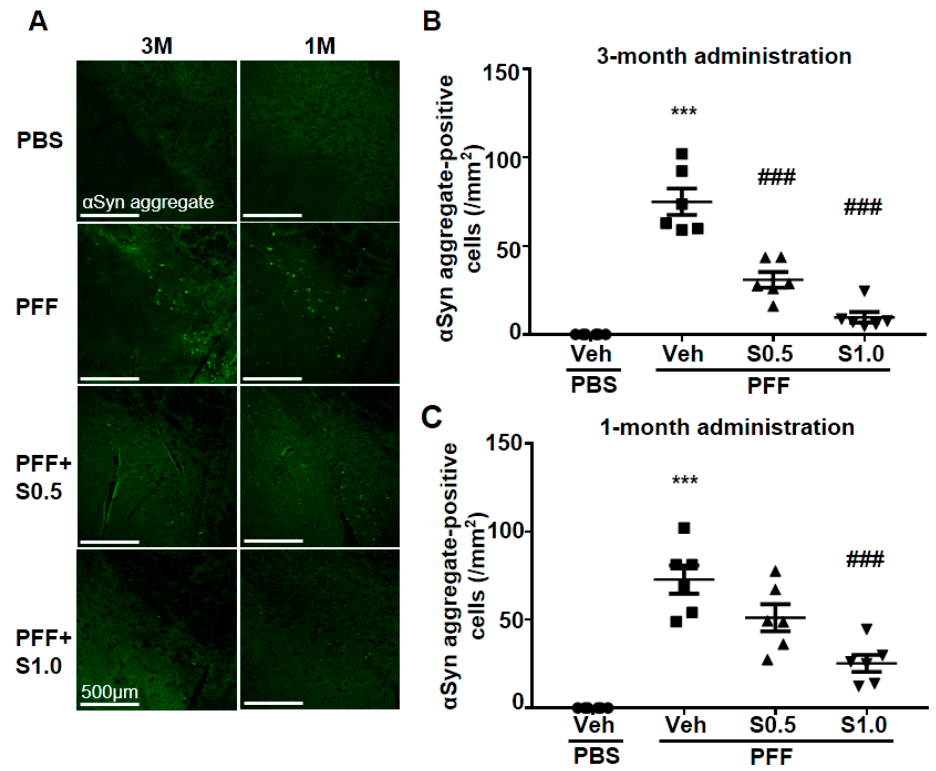
Figure 3. SAK3 treatment prevents the spread of aggregated α -Syn in α -Syn PFF-injected mice. ( A ) Representative immunofluorescence images of fibrous α -Syn in the SNc region in both schedules of this study. Scale bar: 500 µ m. The number of fibrous α -Syn-positive cells was counted in the SNc region for ( B ) 3 months of the SAK3 treatment schedule ( n = 6–8 per group) and ( C ) 1 month of the SAK3 treatment schedule ( n = 7–8 per group). Error bars represent SEM. *** p < 0.001 vs. vehicle-treated PBS-injected mice; ### p < 0.01 vs. vehicle-treated α -Syn PFF-injected mice. Abbreviations: Veh = vehicle; S = SAK3.